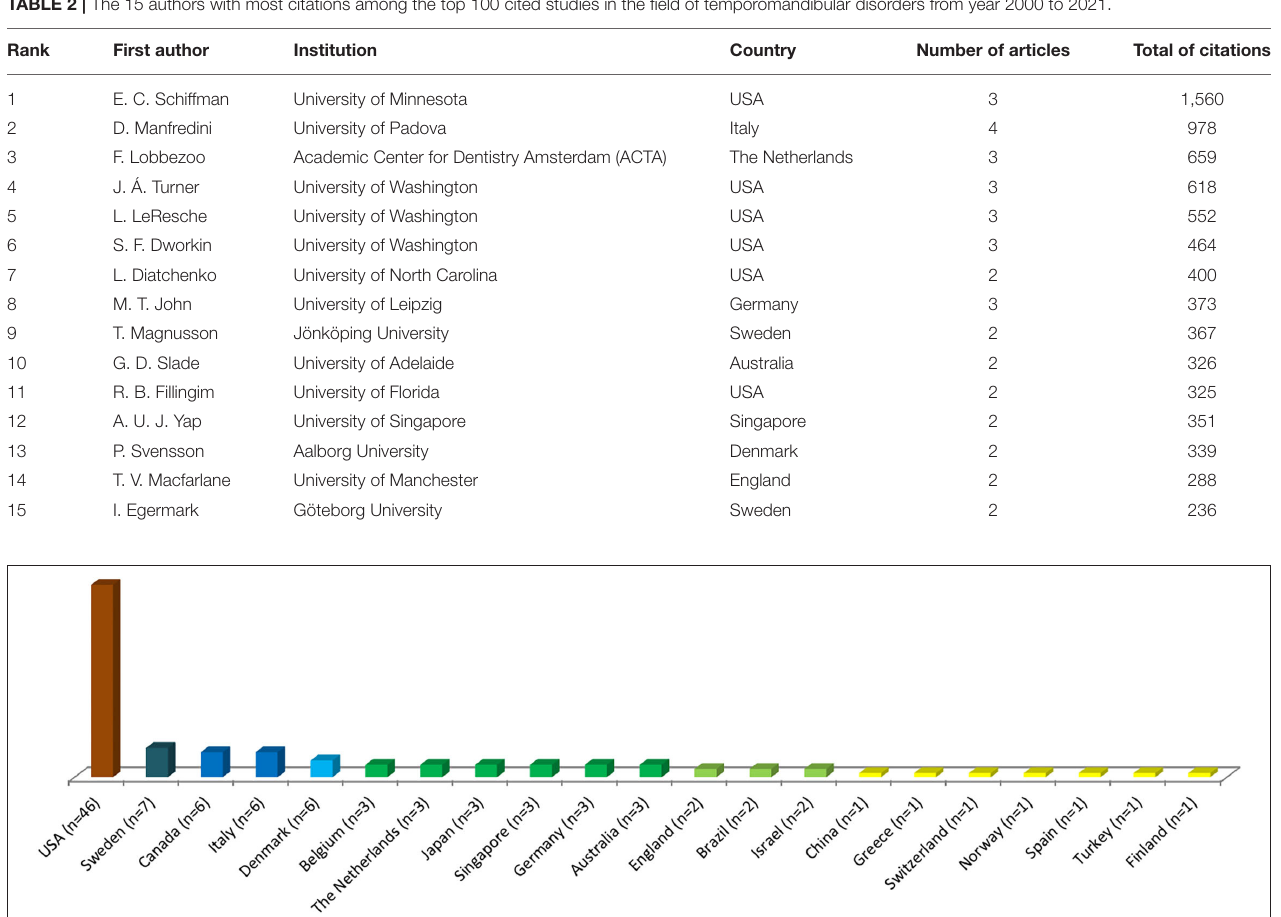
TABLE 2 | The 15 authors with most citations among the top 100 cited studies in the field of temporomandibular disorders from year 2000 to 2021.